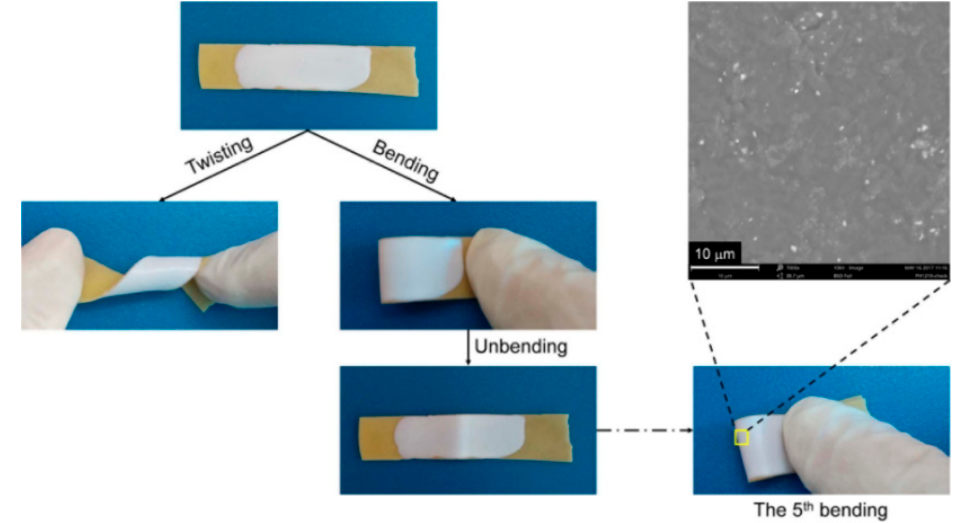
Figure 8. Twisting and bending of a coated substrate.